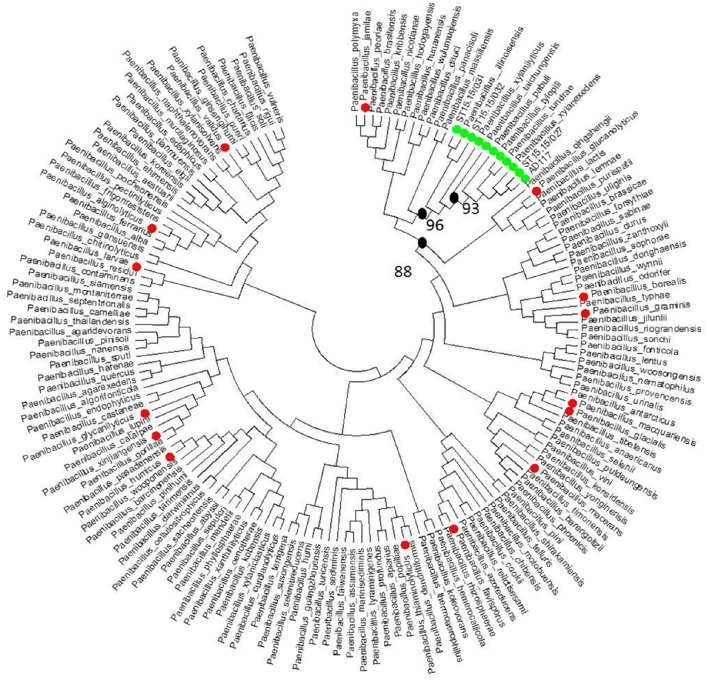
Phylogenetic positioning of Paenibacillus strains showing antagonistic activity against rhizogenic Agrobacterium biovar 1 strains. A maximum likelihood (ML) tree was constructed based on 16S rRNA gene sequences (1390 bp) for all reference (type) strains of all Paenibacillus species (EZtaxon) currently described (163 species) and all other Paenibacillus strains included in this study (Table 2). Only members of a tight cluster of Paenibacillus strains were found to have antagonistic activity against rhizogenic agrobacteria, while strains that were less related to this cluster were not antagonistic. Paenibacillus strains that were tested for antagonistic activity against Agrobacterium biovar 1 (isolate ST15.13/097) are marked with a green or red dot, representing antagonistic or non-antagonistic strains, respectively. Strains without colored dots were not tested for antagonistic activity against Agrobacterium biovar 1. Major bootstrap values (>85%; 1000 replications) are shown at the nodes of the tree.